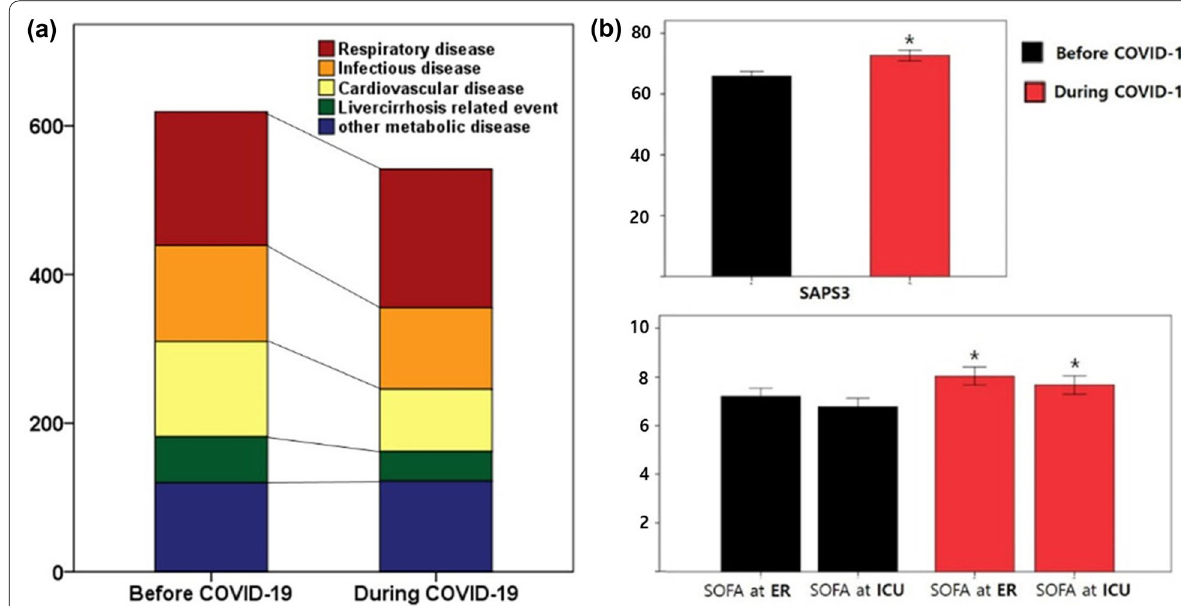
Fig. 1 Patient numbers and their causes of admission ( a ) and severity at admission ( b ) before and during the COVID-19 pandemic. * p < 0.05, compared before and during the COVID-19 pandemic. COVID-19, coronavirus disease